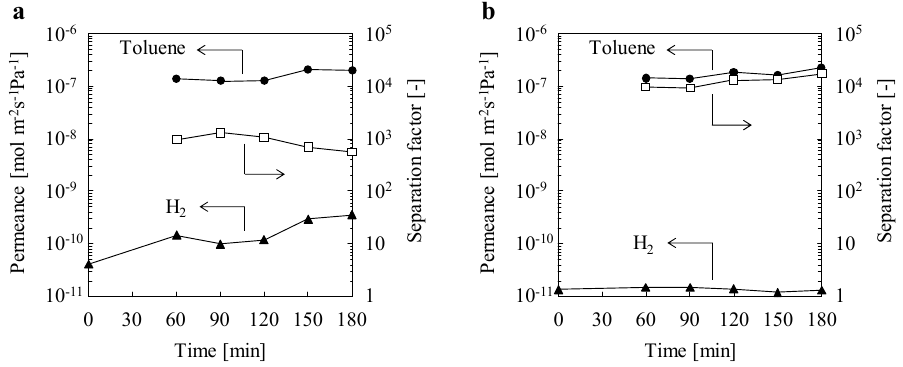
Figure 3. Time courses of toluene and H 2 permeances and separation factor for ( a ) SILM and ( b ) the ILOS membrane. ( ● toluene permeance, ▲ H 2 permeance, □ separation factor ). The maximum toluene/H 2 separation factor of SILM was 1280 after 90 min. The toluene and H 2 permeances were 1.3 × 10 − 7 and 4.1 × 10 − 11 mol m − 2 s − 1 Pa − 1 , respectively (Figure 3a). The permeation